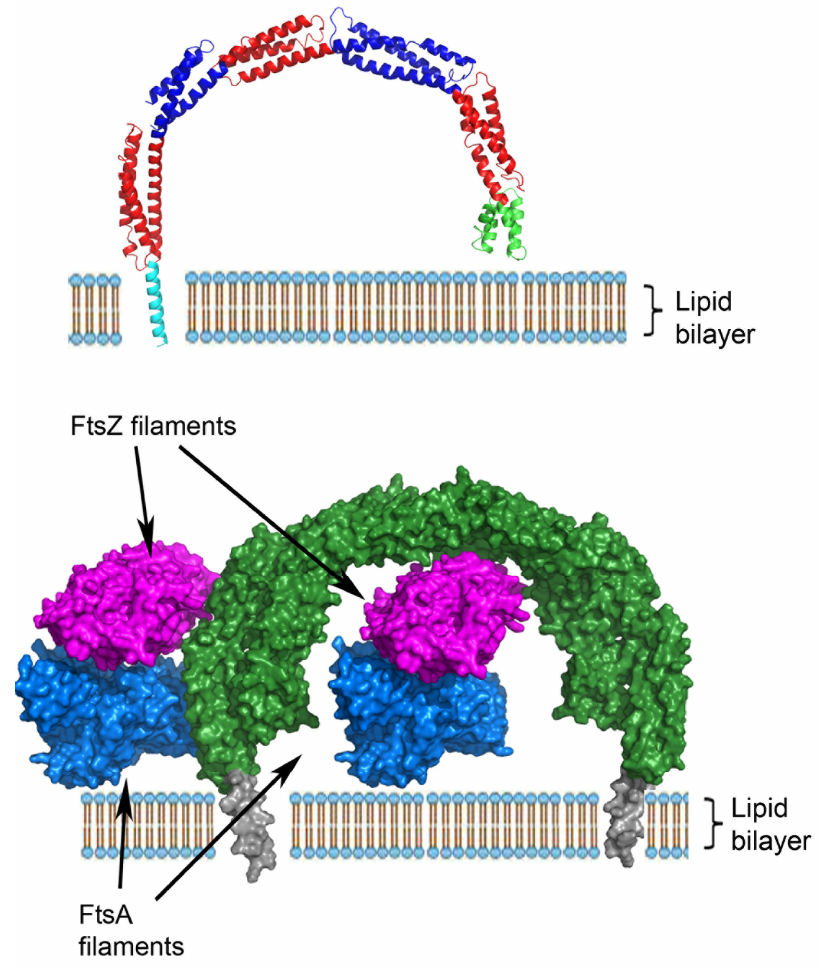
FIGURE 2: Top – Model of the integration of B. subtilis EzrA into the lipid bilayer. The modelled N-terminal helix is coloured cyan, the remainder of the cytoplasmic domain is coloured as in Figure 1. Bottom – Model for the interaction of EzrA (green, with the modelled TM helix grey) with FtsZ protofil- aments (magenta) and the FtsZ membrane anchor, FtsA (blue) within the divisome; the FtsZ and FtsA filaments are viewed along the long axis of the respective filaments. EzrA is represented in an anti-parallel dimer that is observed in the crystal lattice and is supported by in vivo two hybrid studies. There is sufficient space to accommodate both FtsA and FtsZ in the gap between the membrane and the inside of the arch- shaped EzrA